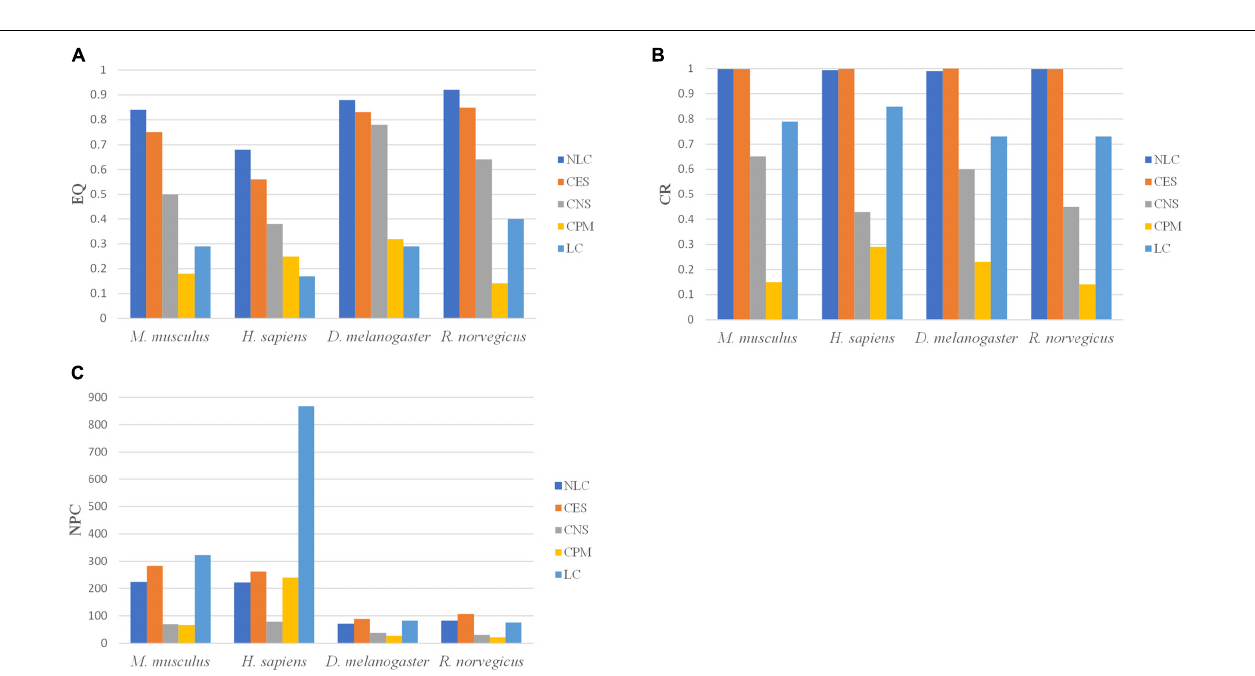
FIGURE 8 | The division results of five algorithms in PPI networks including three indicators: (A) EQ, (B) CR, and (C) NPC.